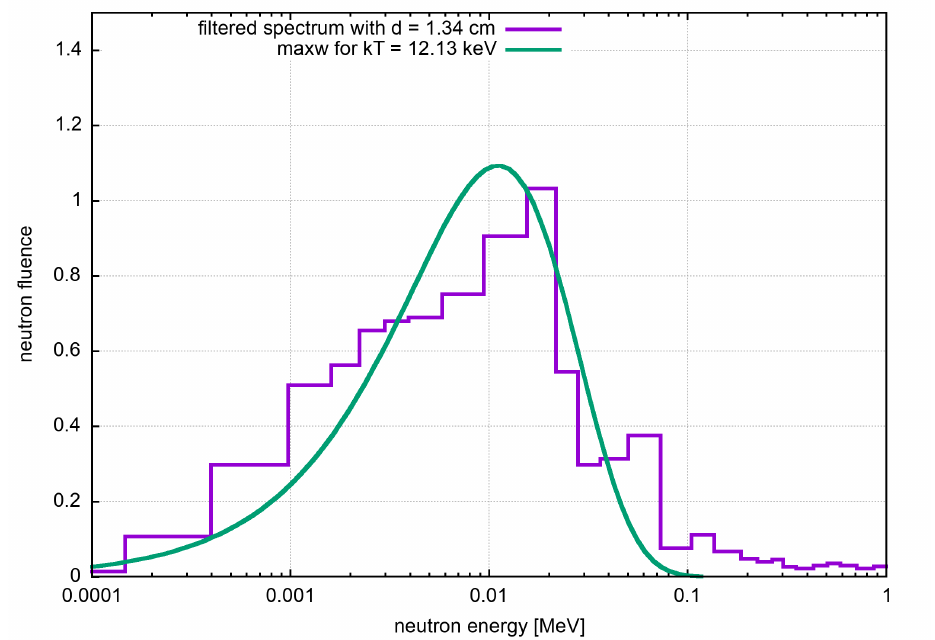
Figure 8. Preliminary results of simulations for the neutron energy distribution attainable at the NEAR station using a 30 cm thick aluminium fluoride moderator and a thin (1.34 cm) boron filter [92]. See text for